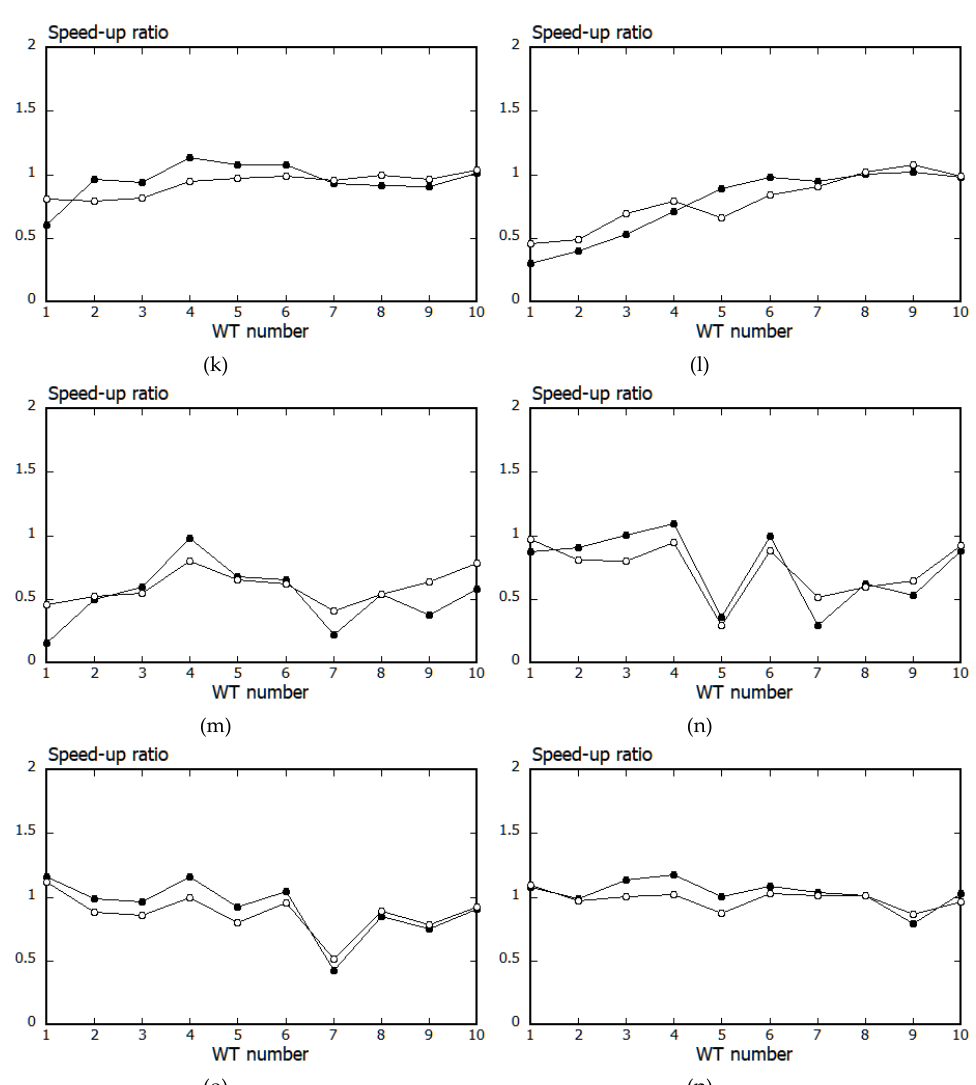
Figure 20. Comparison of local speed-up ratios obtained from wind tunnel experiments at wind turbine hub height: ( a ) N, ( b ) NNE, ( c ) NE, ( d ) ENI, ( e ) E, ( f ) ESE, ( g ) SE, ( h ) SSE, ( i ) S, ( j ) SSW, ( k ) SW, ( l ) WSW, ( m ) W, ( n ) WNW, ( o ) NW, and ( p ) NNW. The unfilled symbol shows the result of the scale